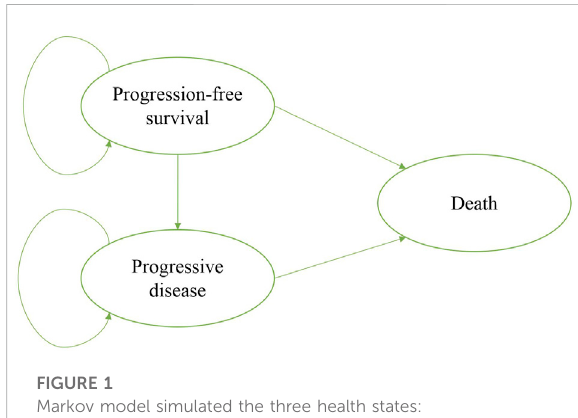
FIGURE 1 Markov model simulated the three health states: progression-free survival, progressive disease, and